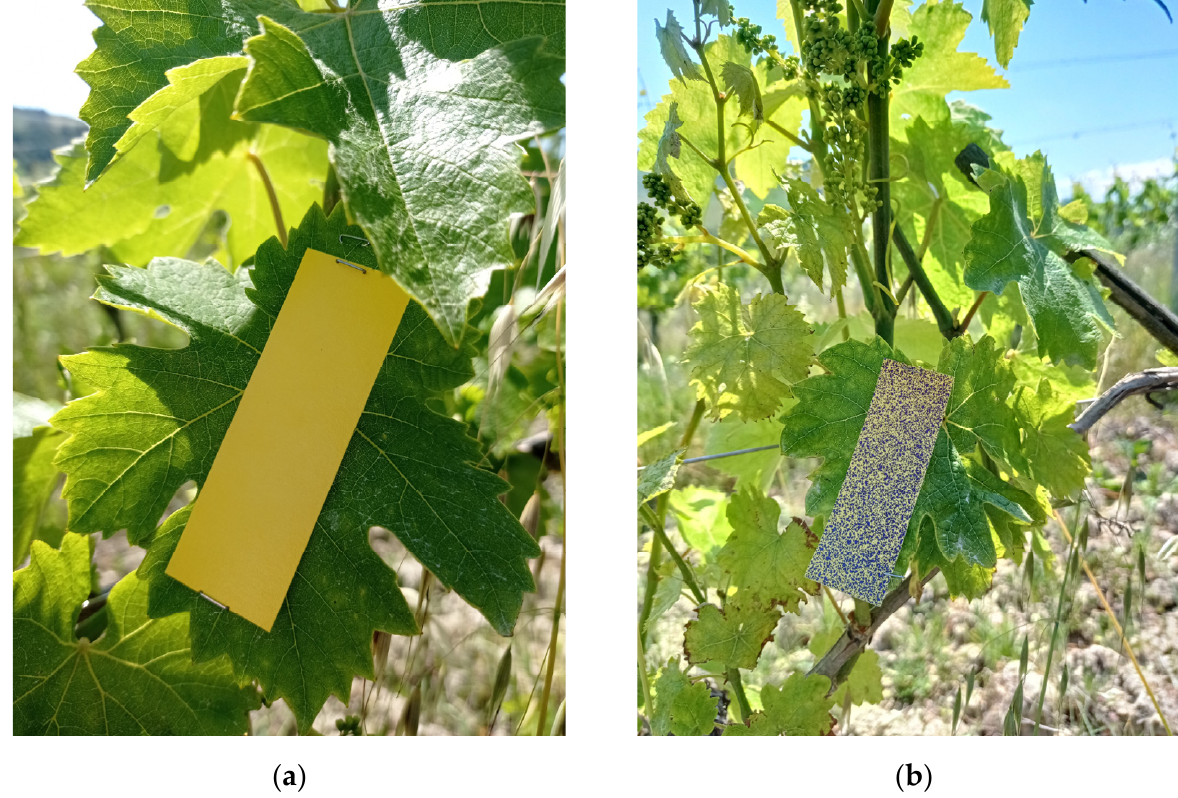
Figure 5. Details of water-sensitive papers: ( a ) Before the distribution of agrochemicals. ( b ) After distribution with blue areas that represent the impact area.